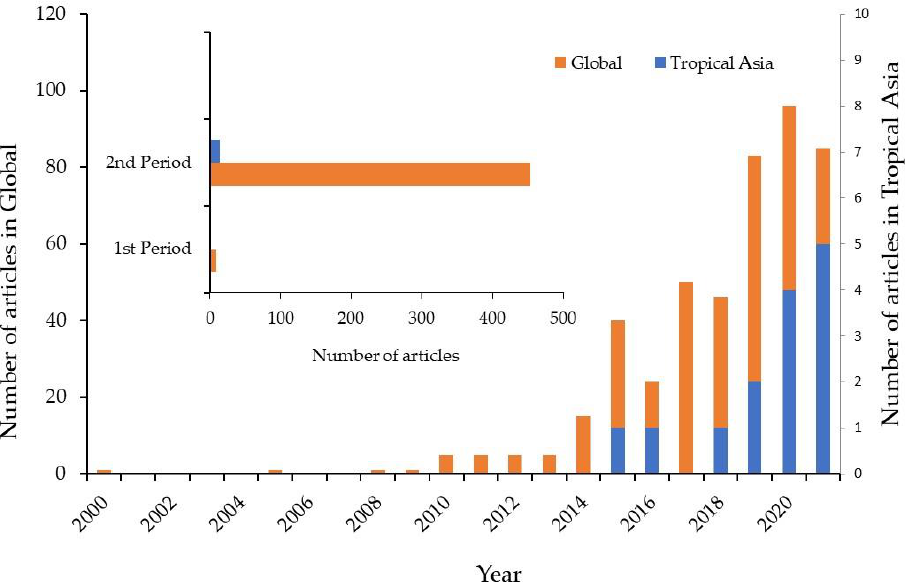
Figure 2. Number of studies published from 2000 to 2020.